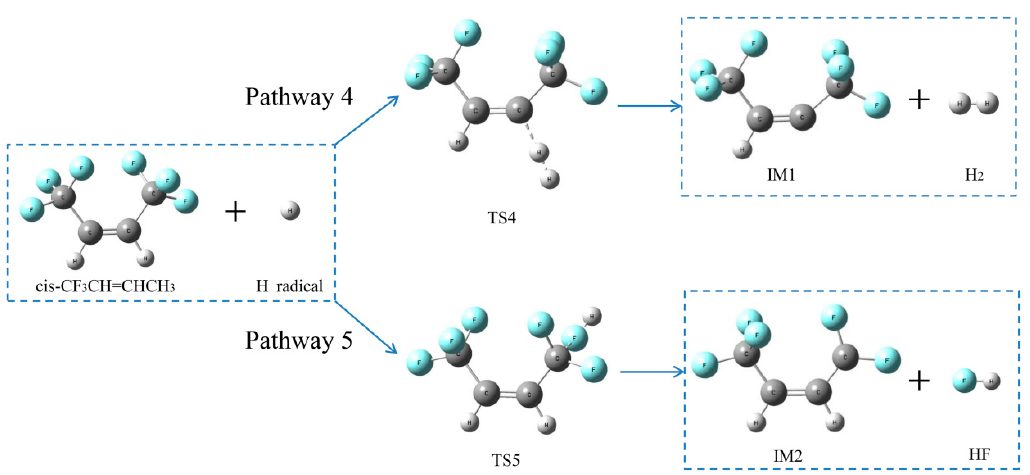
Figure 15. Two proposed pathways for cis ‐ CF 3 CH=CHCF 3 + H• reactions.